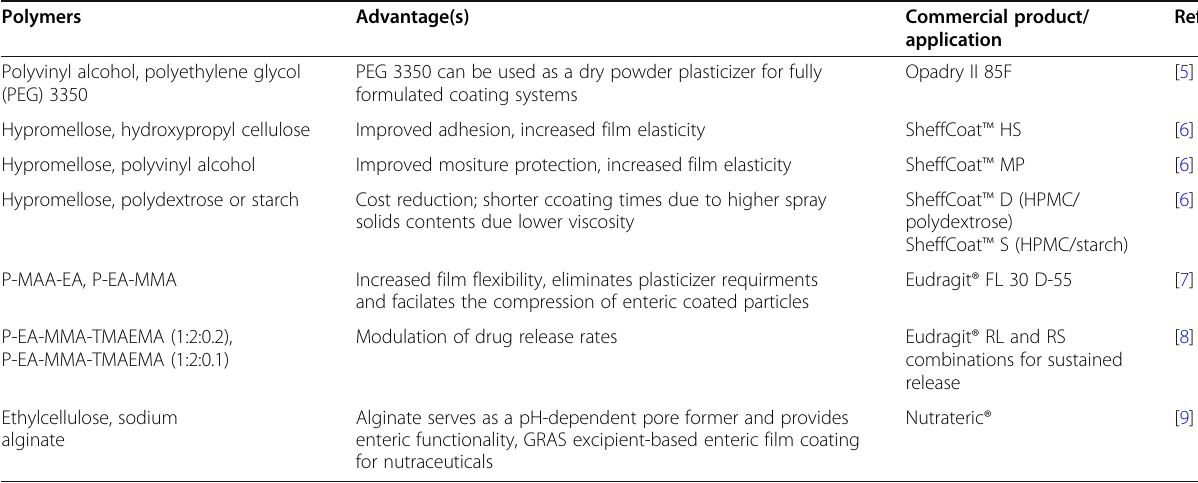
Table 3 Polymer blends used in film coatings